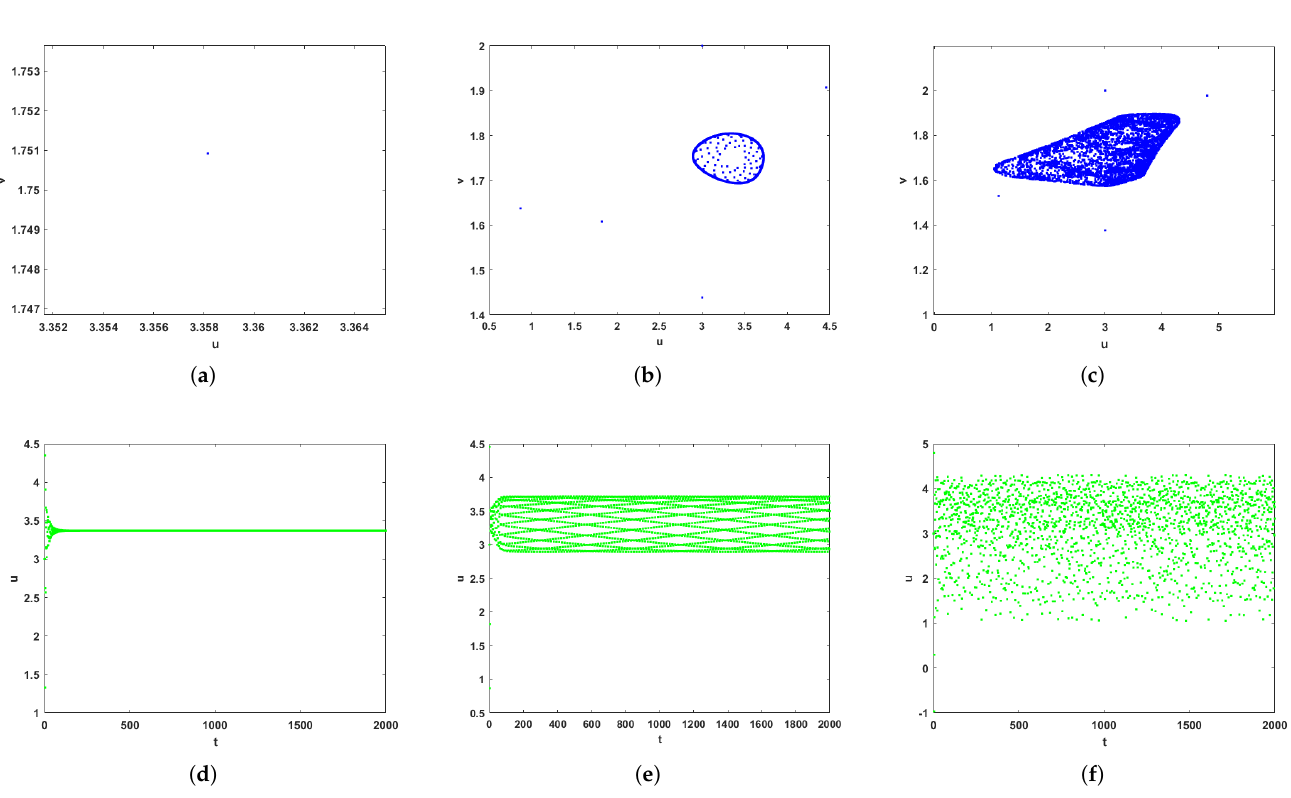
Figure 3. Phase portraits and solution portraits for various values of δ corresponding to Figure 2a. ( a ) δ = 5.2. ( b ) δ = 5.4. ( c ) δ = 6. ( d ) solution portrait for δ = 5.2. ( e ) solution portrait for δ = 5.4. ( f ) solution portrait for δ =